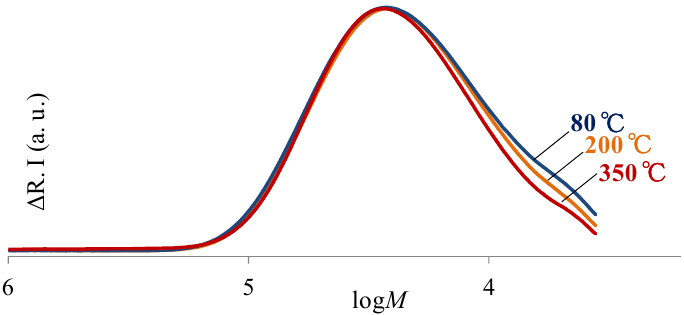
Figure 5. The SEC profiles of the polyimide films prepared from CpODA and 3,4 ′ -DDE using a chemical imidization method. Cure temperature: 80 °C (blue line); 200 °C (orange line); 350 °C (red line).